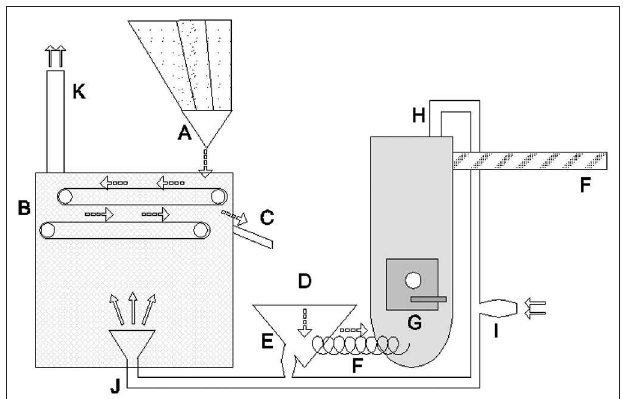
FIGURE 1 | Schematic diagram of multi-fuel boiler (solid arrows show air flow direction, while dotted arrows show biomass flow direction).